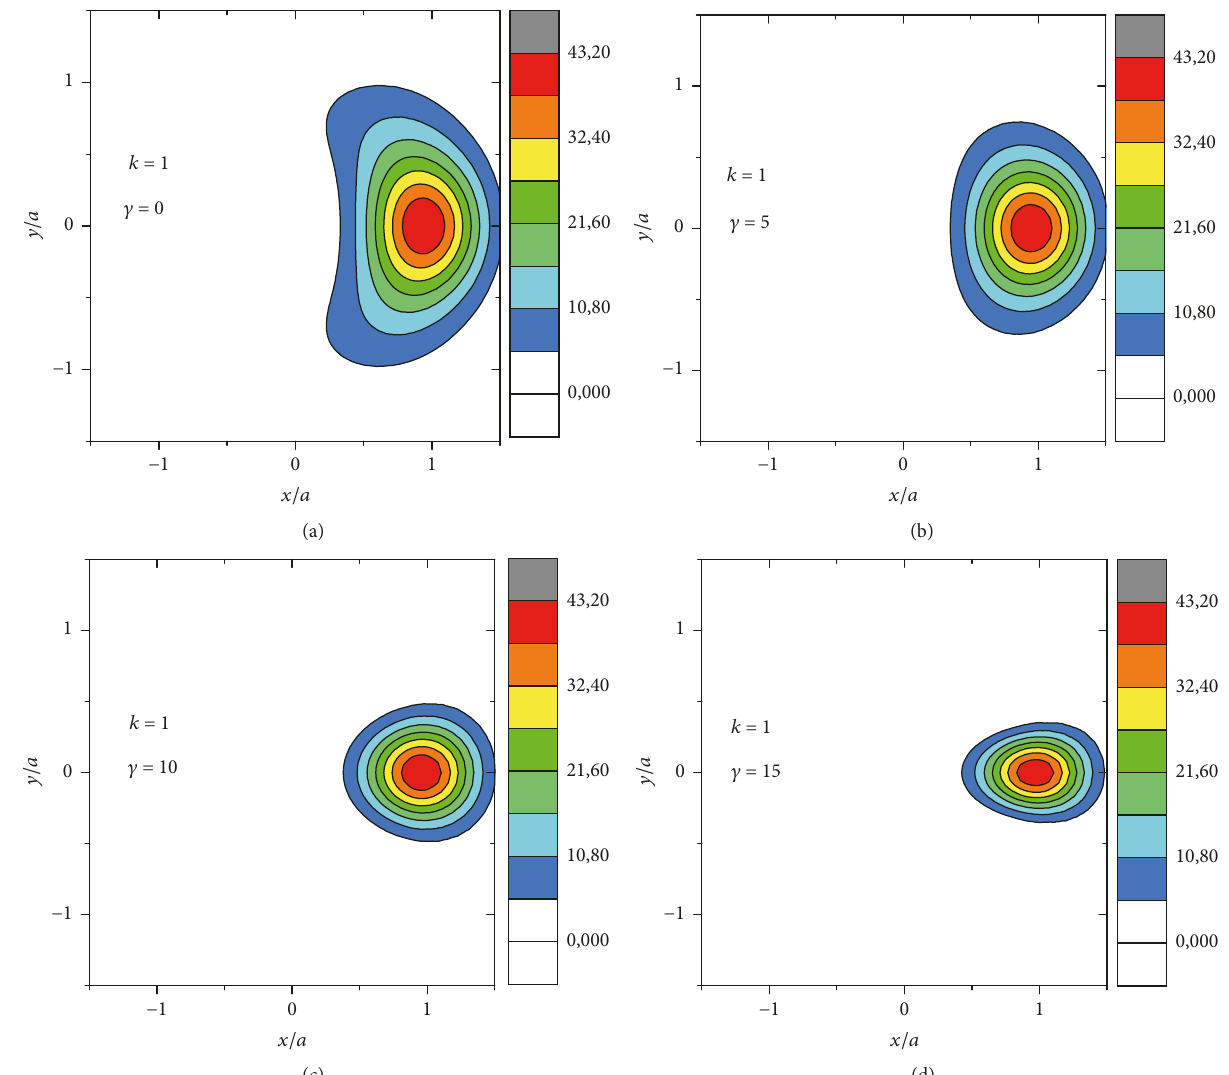
Figure 6: Charge distribution for off-center donor ( 𝜌 𝑖 = 20 nm) in the ground state (a, b) and in the first excited state (c, d) for 𝛾 = 0, 5, 10, 15 in circular QR.